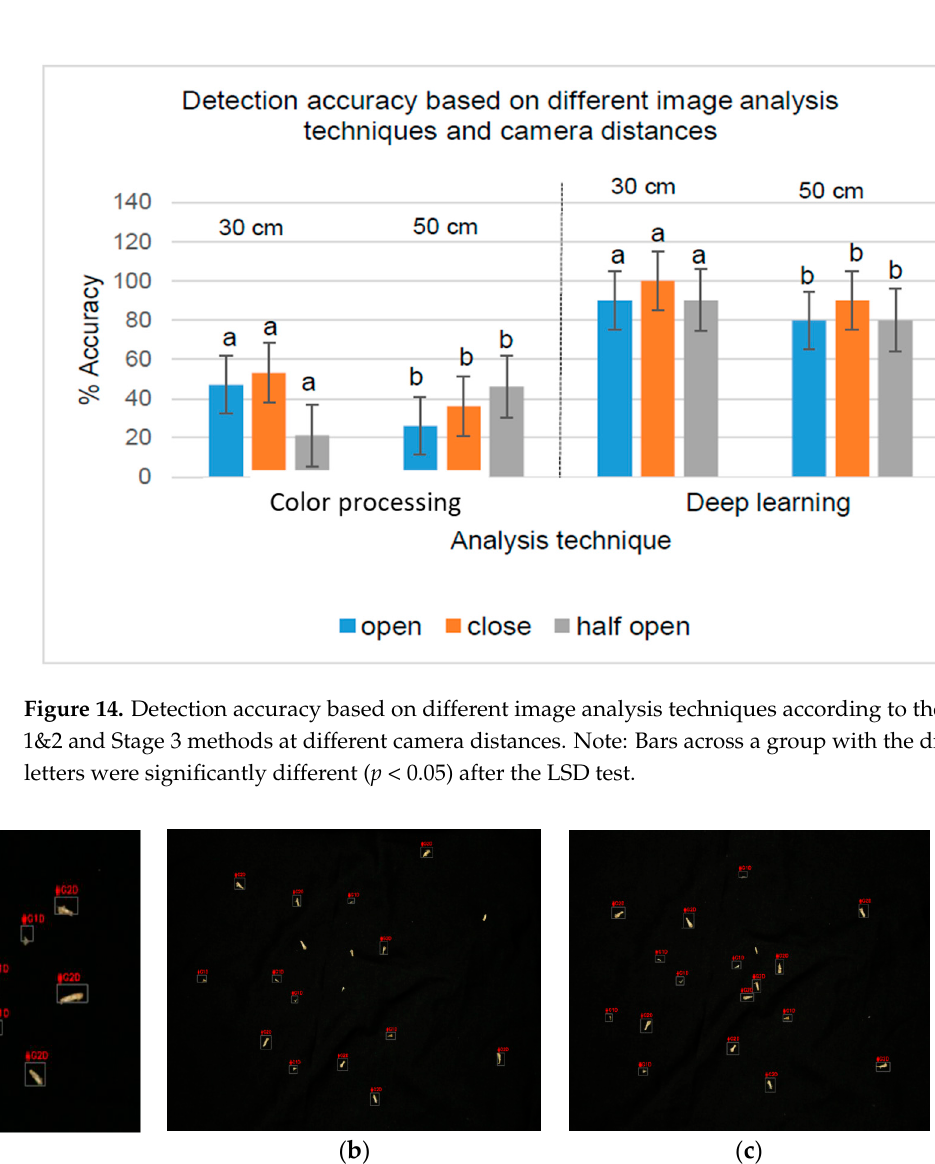
Figure 15. Classification of bagworm stages according to features extracted and marked with bounding box: ( a ) Test 1, ( b ) Test 2, and ( c ) Test 3. Table 4. Bagworm group classification performance between algorithm and human.